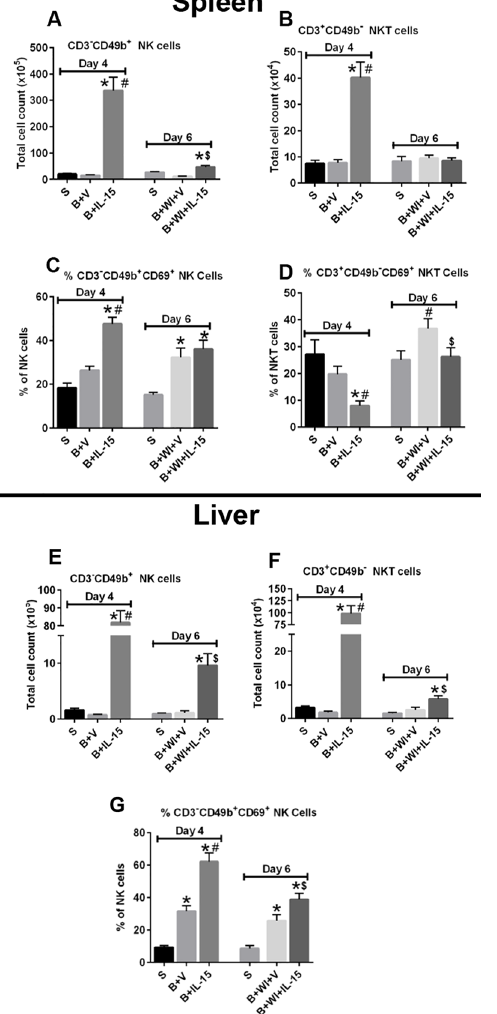
Fig 5. IL-15 SA treatment elicits expansion of NK and NKT cells post burn injury and wound infection causes their decline. Upper half and lower half of the panel depicts cell counts and activation status (CD69 + ) of NK (CD3 - CD49b + ) and NKT (CD3 + CD49b - ) cells in the spleen and liver respectively. The graphs A and E depict NK cell counts in the spleen and liver respectively; and the graphs B and F show the NKT cell counts in the spleen and liver respectively. The graphs C and G depict NK cell CD69 expression in the spleen and liver respectively; and the graph D shows the NKT cell CD69 expression in the spleen. n = 8 – 10 in each group and P < 0.05. * significantly different as compared to respective day 4 and day 6 sham groups; #significantly different from day 4 burn injury group (B+V), and $ — significantly different from day 6 burn injury + wound infection + vehicle treated group